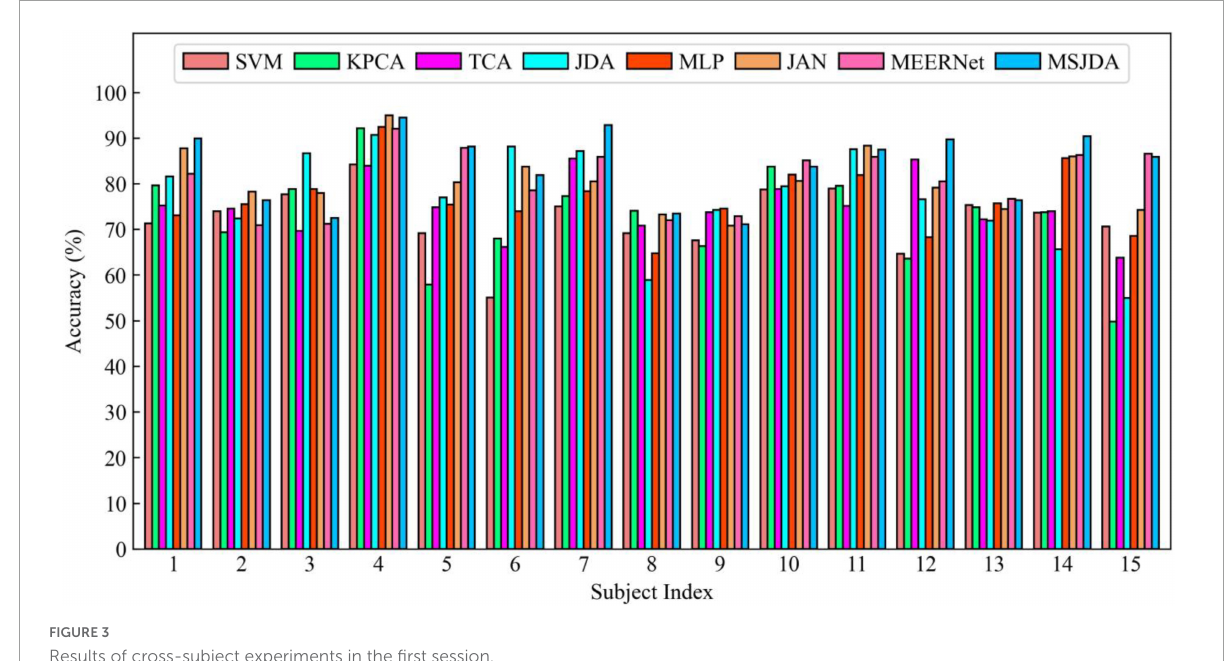
FIGURE3 Results of cross-subject experiments in the first session.